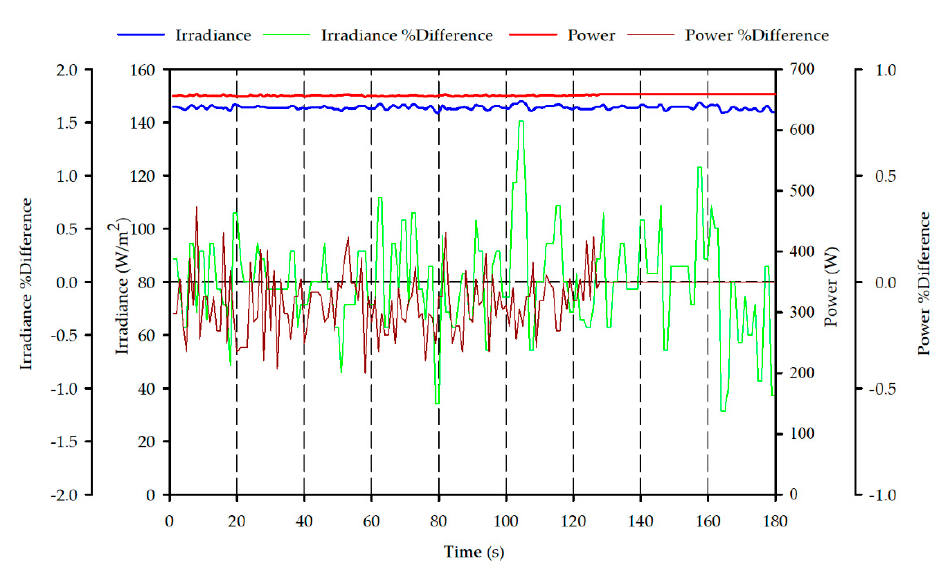
Figure 7. Xenon arc lamp power and irradiance distribution at cold start.